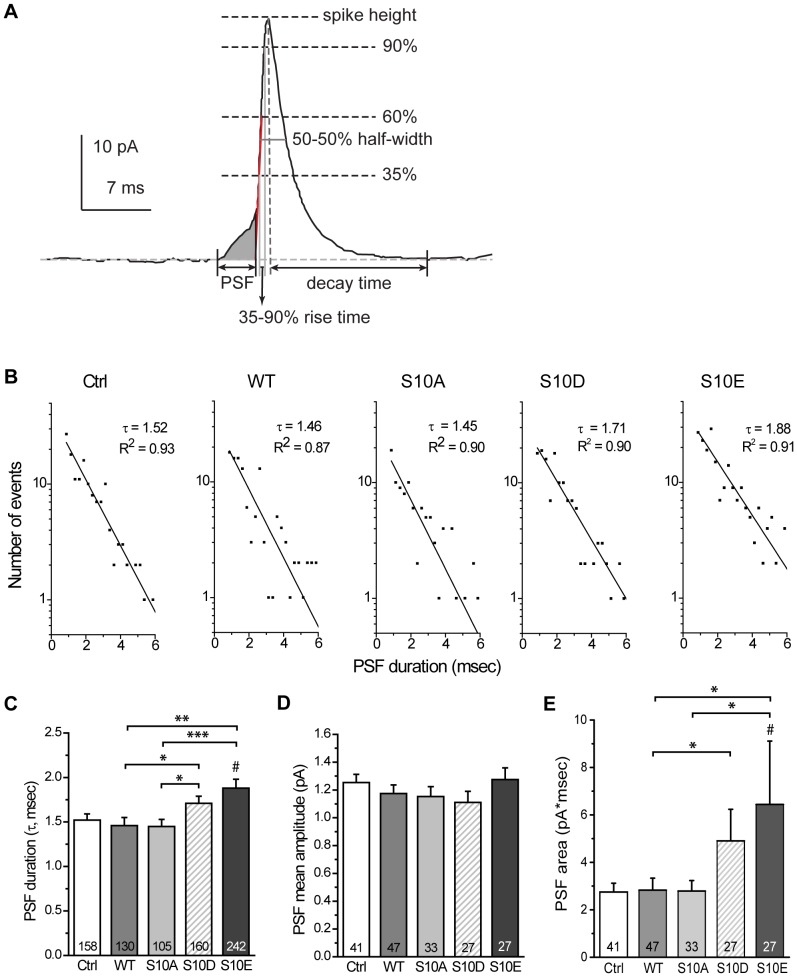
Characteristics of the PSF in cells overexpressing CSP and its phosphomutants.
A, The amperometric recording for a full-fusion event from a single vesicle. The prespike foot (PSF, shown as shaded area) reports the initial opening of a fusion pore and the spike begins when the fusion pore enters into the dilation phase. The PSF lifetime was measured from onset (the current rising to 1×RMS noise above the baseline current) to end point (the intersection between the baseline and the red line going through the rise phase from 35 to 60% of the peak). The features of PSF and spikes analyzed in this study are illustrated (see Materials and Methods for detail). B, PSF lifetime distributions were constructed for the indicated groups. Distributions were fitted by the single-exponential decay function N(t) = N(0)×exp (−t/τ) to yield the mean PSF duration τ (the goodness of the fits: R2∼0.90). C, τ obtained in (B) for each group. Numbers in bars indicate the number of PSF used for each calculation. D, PSF mean amplitudes calculated by the cellular means method. E, PSF areas calculated by the cellular means method. For D and E, numbers in bars indicate the number of cells used for each calculation.